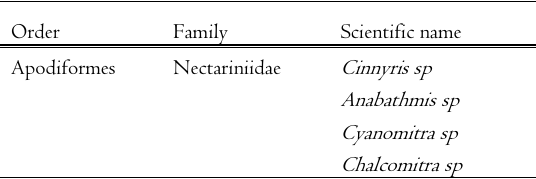
T ABLE 2: Birds species found on A. comosus flowers in the Central Region of Ghana